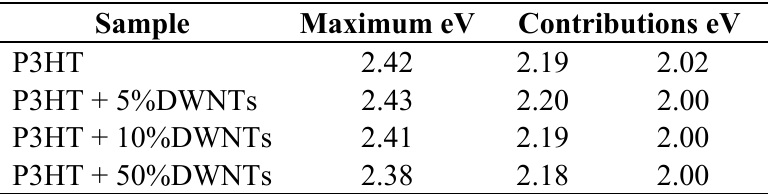
Table 1. Analysis of UV-Vis